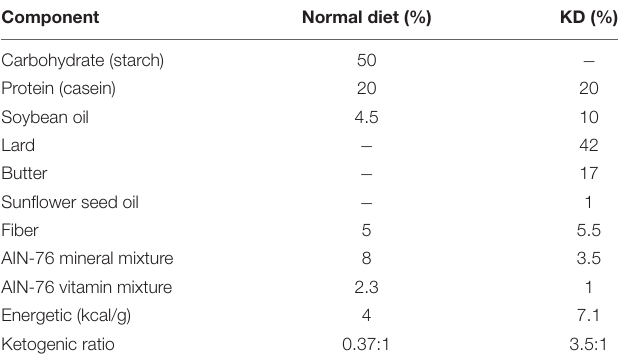
TABLE 1 | Composition of normal and